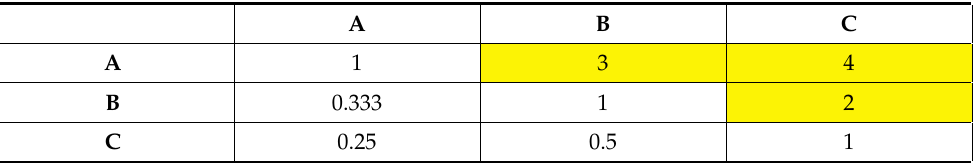
Table 2. Example of a 3 × 3 PCM.